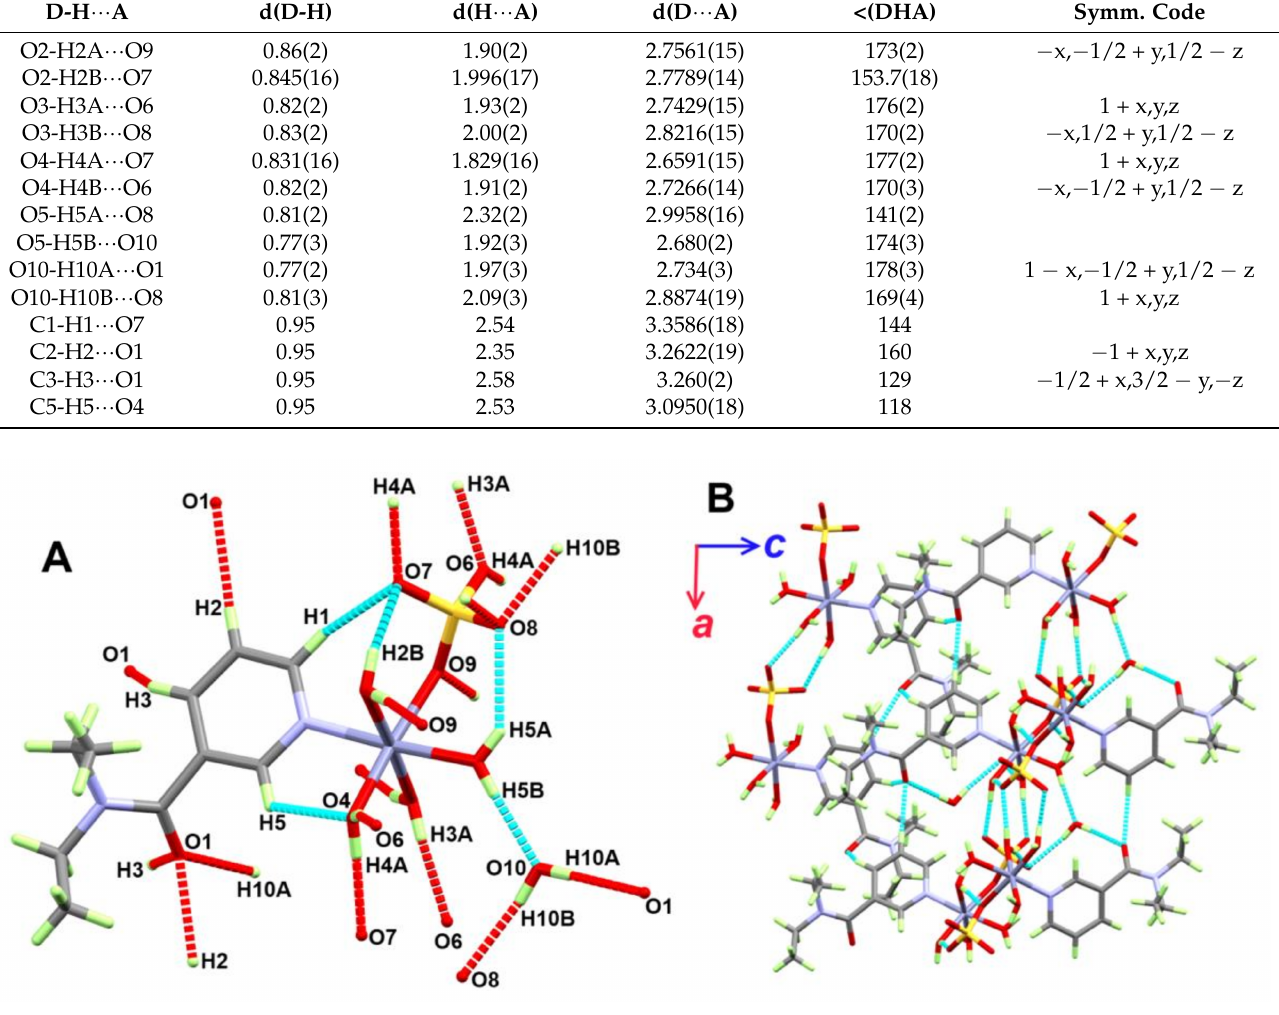
Figure 5. Intra- and intermolecular contacts ( A ) through O-H ··· O hydrogen bonds and packing of 2 along the ac plane ( B